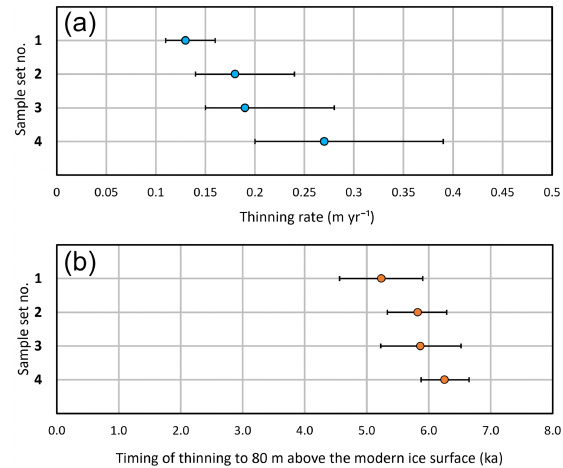
Figure 5. Thinning rates and age constraints from linear regression analysis. (a) Range in thinning rates (myr − 1 ) compiled from linear regression histograms (Fig. B1) and (b) uncertainty range in best- fit timing of thinning to 80m above the modern ice surface (ka) calculated for each of the different input data points to the linear re- gression Monte Carlo simulation (Fig. B2). Blue circles in (a) rep- resent the median thinning rate, and orange circles in (b) represent the endpoint of the best-fit thinning line. Error bars represent 68% confidence interval uncertainty estimates in (a) and 95% confidence interval uncertainty estimates in (b) . “Sample set no.” indicates the four different age datasets used for linear regression analysis, which are described in Sect. 3.1. Note (b) that sample set 1 and 4 linear re- gression best-fit end ages correspond to the linear regression models displayed in Fig.